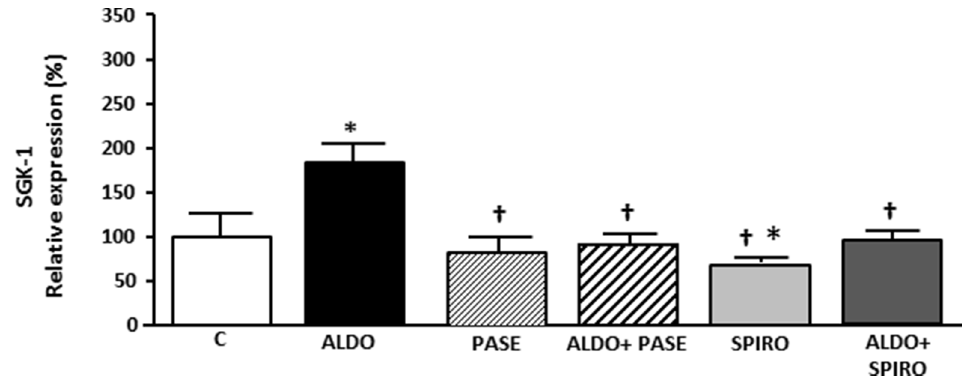
Figure 3. SGK-1 mRNA levels in control (C), aldosterone treated animals (ALDO), PASE (PASE), aldosterone plus PASE treated animals (ALDO + PASE), spironolactone treated animals (SPIRO) and aldosterone-salt plus spironolactone (ALDO + SPIRO). Data are